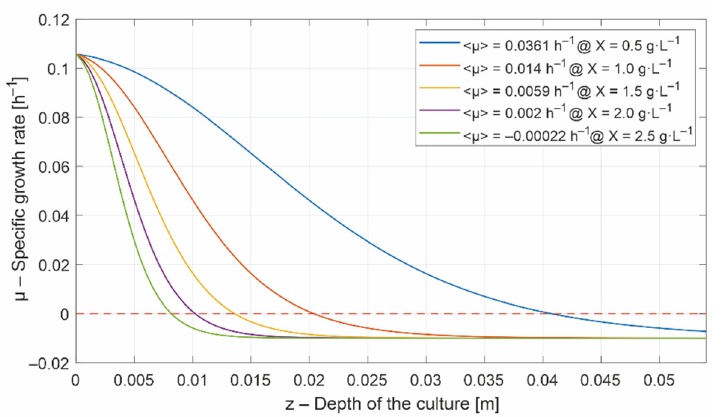
Figure 3. The decrease of the specific growth rate with the depth of the culture, at an incident light intensity of 500 μ mol ∙ m − 2 ∙ s − 1 .